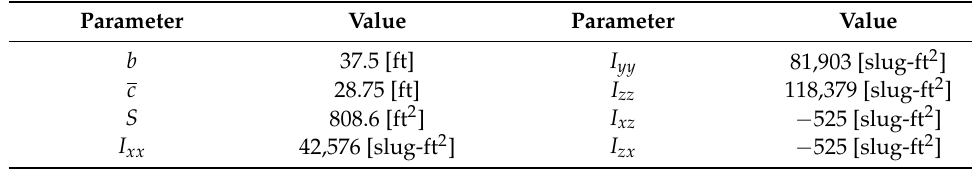
Table 1. Wing planform and inertia parameters for the model.